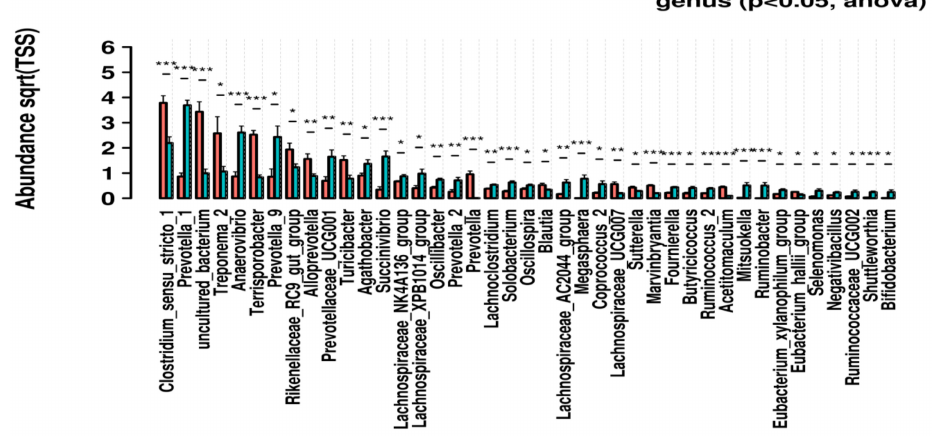
Figure 3. Genus-level univariate analysis through ANOVA test, Red color indicates the stage L, and blue is stage LD. X -axis representing the samples and Y -axis representing the relative OTU counts. * p ≤ 0.05, ** p ≤ 0.01, *** p ≤ 0.001, **** p ≤